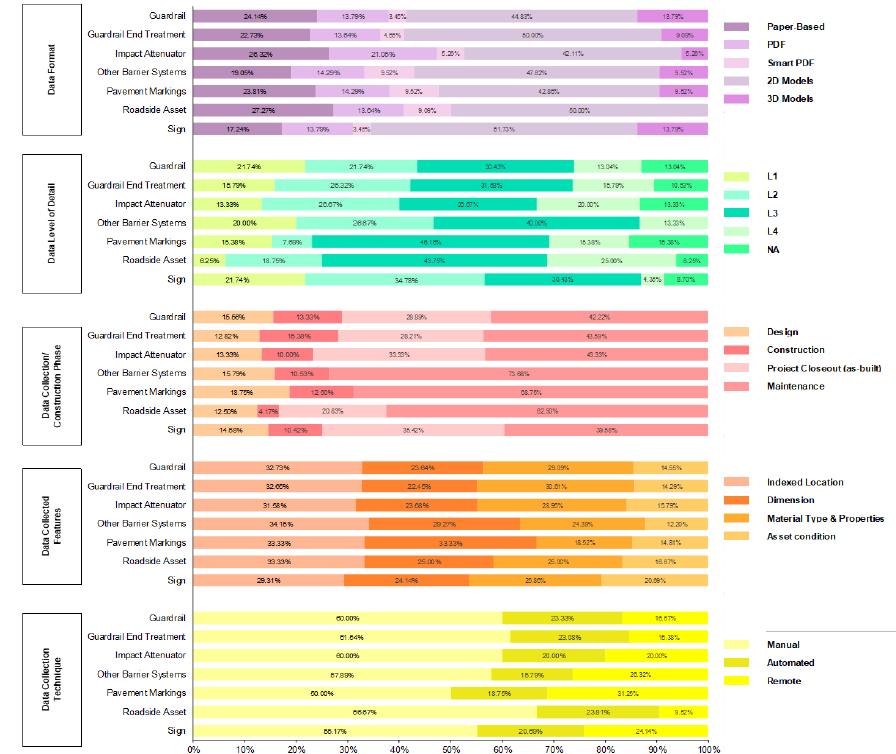
Figure 3 . Stacked and clustered results for major Data Collection variables and variable